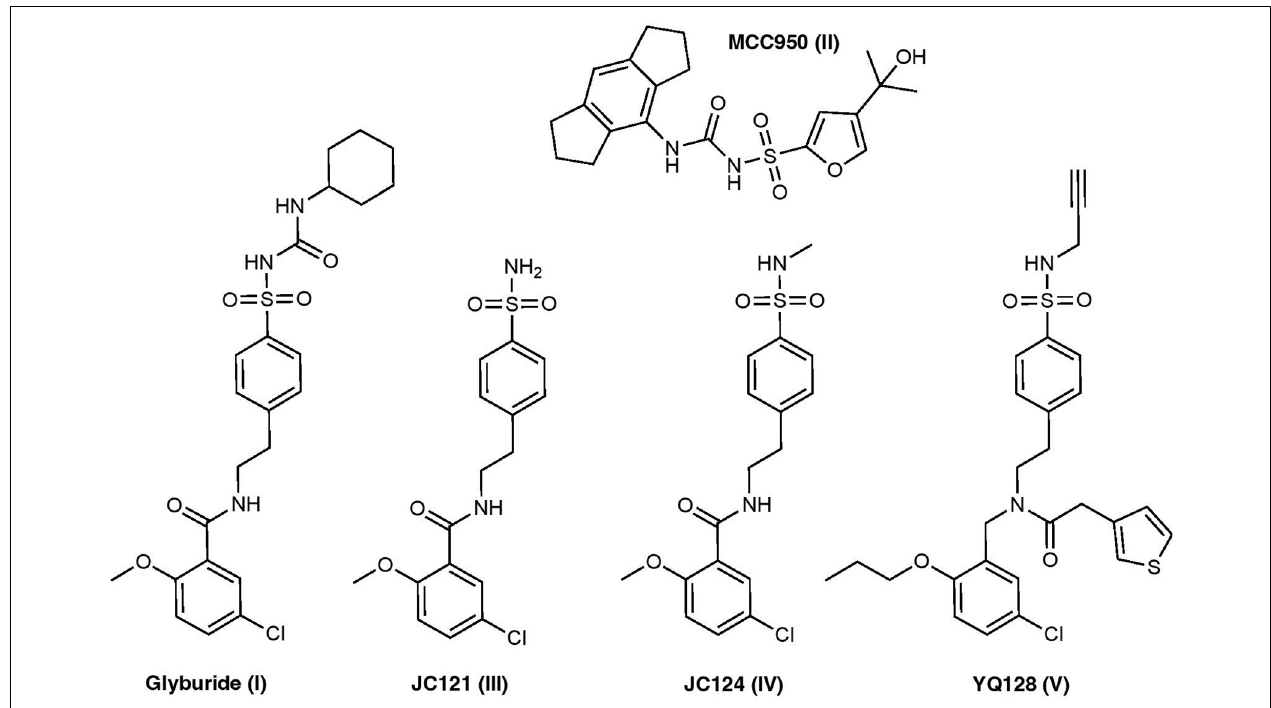
FIGURE 2 | Sulfonamide-based NLRP3 inhibitors